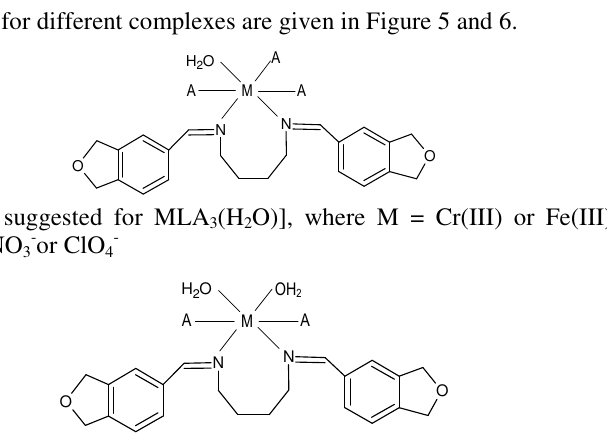
Figure 6. Structure suggested for[MLA Br - or ClO 4-